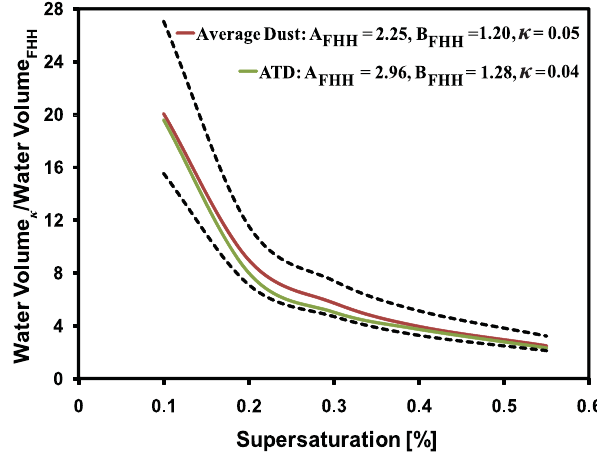
Fig. 7. Ratio of water volume required by KT over FHH-AT to activate CCN as a function of supersaturation. Simulations are per- formed with values of adsorption ( A FHH , B FHH ) and κ for average dust aerosol. Dashed lines represent simulation representing upper and lower limit of dust relevant adsorption